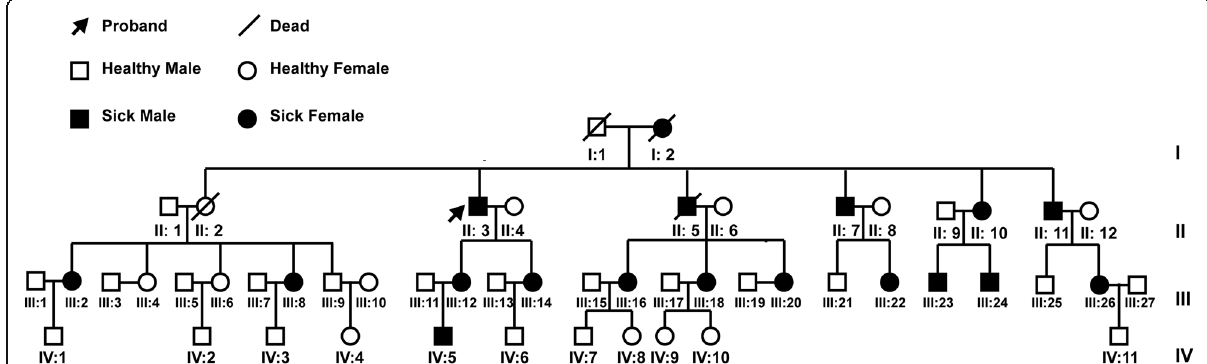
Fig. 1 The four-generation pedigree with the mutation p. Asn278Lys in the GLA gene. Roman numerals indicate generations, and individuals within a generation are numbered from left to right. The proband (II: 3) is denoted with an arrow. Oblique lines indicate patients who are already dead. Filled squares and circles indicate male and female patients, respectively. Open symbols indicate unaffected individuals in this family